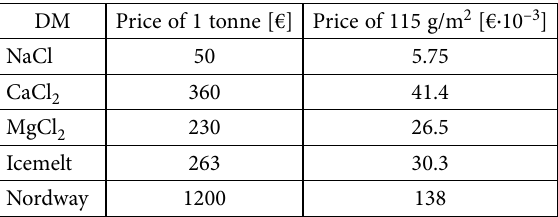
Table 4. Prices for all tested DMs in 2015